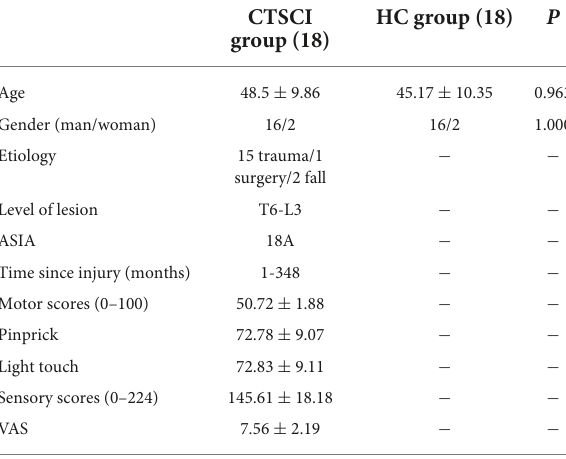
TABLE 1 Clinical data of 18 complete thoracolumbar spinal cord injury (CTSCI) patients and 18 healthy controls